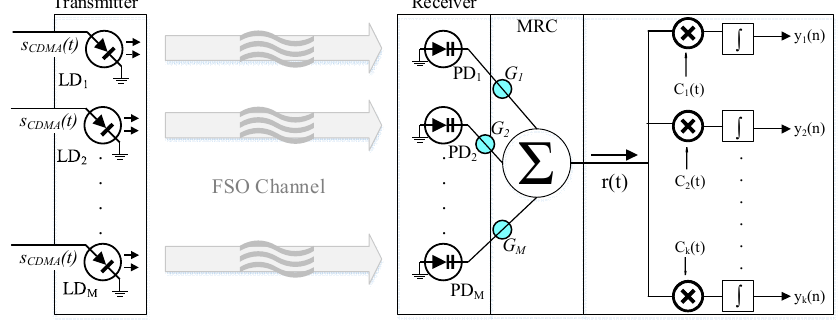
Figure 2. Block diagram of the CDMA RoFSO system with receivers’ spatial diversity.